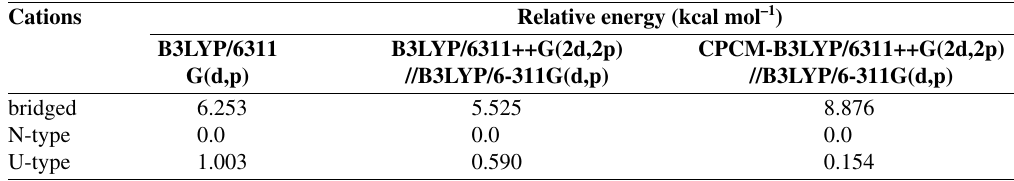
Abbasoglu: Theoretical Investigation of Electrophilic Transannular ...